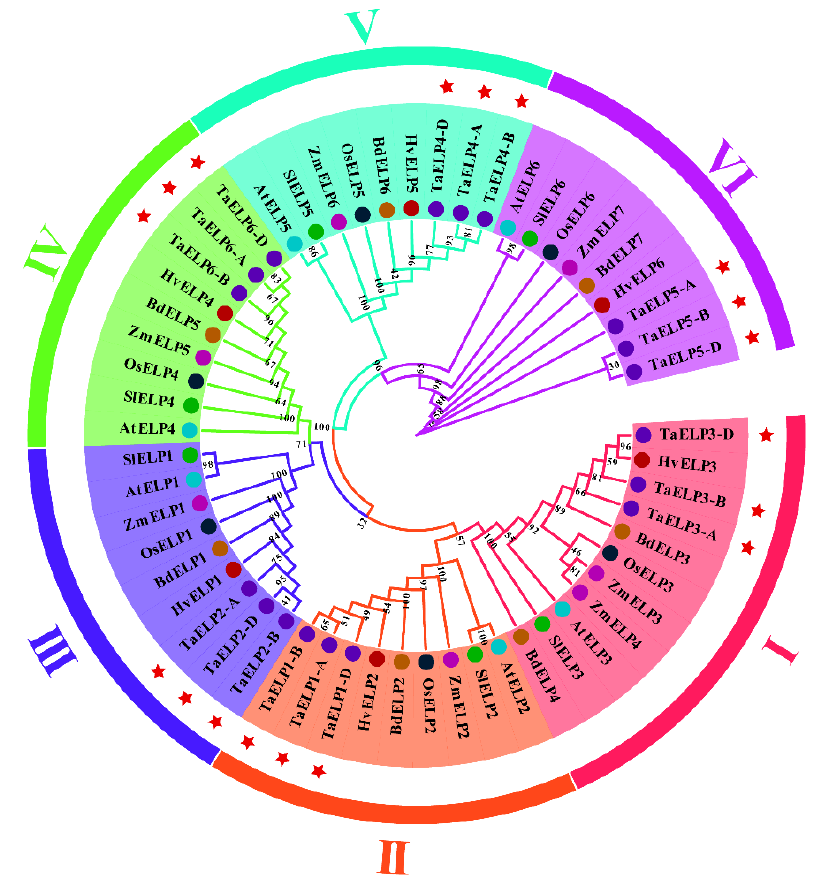
Figure 2. Phylogenetic analysis of TaELP proteins. The tree was generated using MEGA X with the neighbor-joining (NJ) method with 1000 bootstrap values. TaELPs are represented by red five-pointed stars. The abbreviations represent the species as follows: Ta, Triticum aestivum ; Os, Oryza sativa ; Zm, Zea mays ; At, Arabidopsis thaliana ; Hv, Hordeum vulgare ; Bd, Brachypodium distachyon ; Sl, Solanum lycopersicum . All the species and protein ID used for constructing the tree are presented in Table